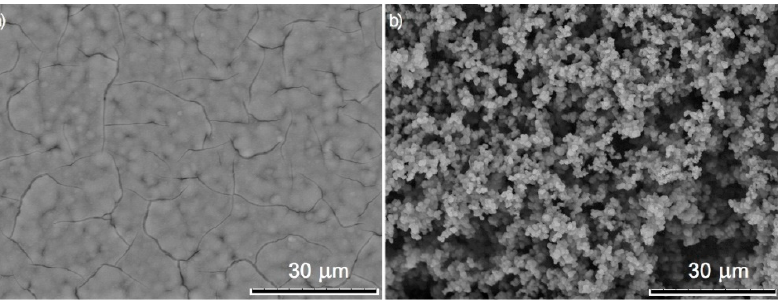
Figure 2. SEM images of ( a ) PEDOT:PSS and ( b ) PAz layers deposited on carbon electrode.